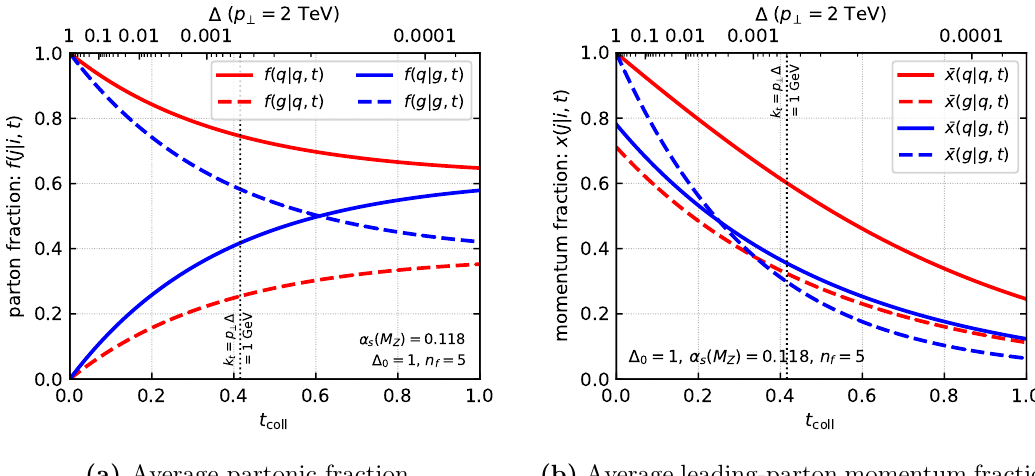
Figure 2. Average parton fraction (left) and longitudinal momentum (right) as a function of the evolution time variable t coll . The red (blue) curves correspond to a quark (gluon) initial parton. The solid (dashed) curves correspond to a quark (gluon) leading parton at time t coll . The top axis shows the angle corresponding to t coll for a 2-TeV jet. The t coll axis extends signi(cid:12)cantly beyond the typical perturbative region so as to help illustrate the asymptotic